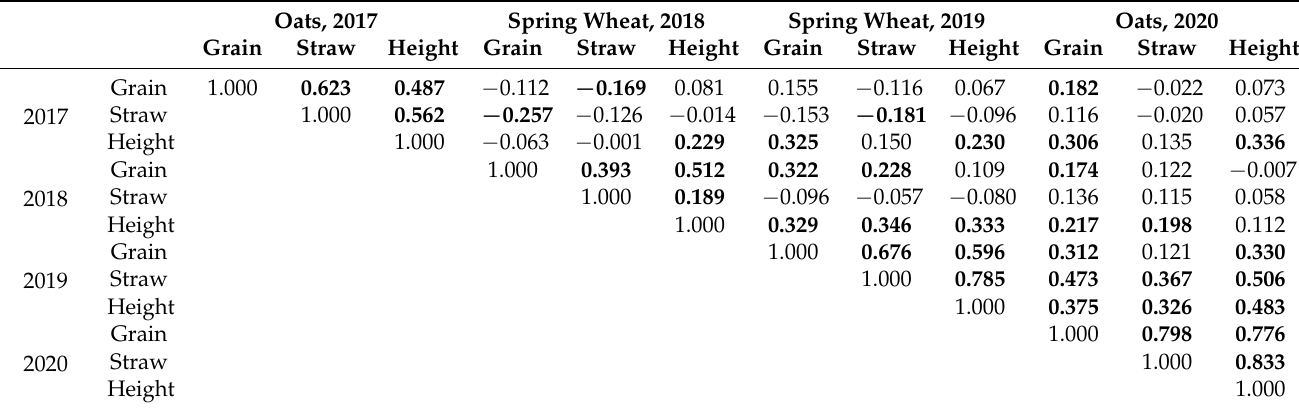
Table 2. Correlation coefficients (r) between grain, straw, and height in the study years. The correlation coefficients in bold are significant at p <